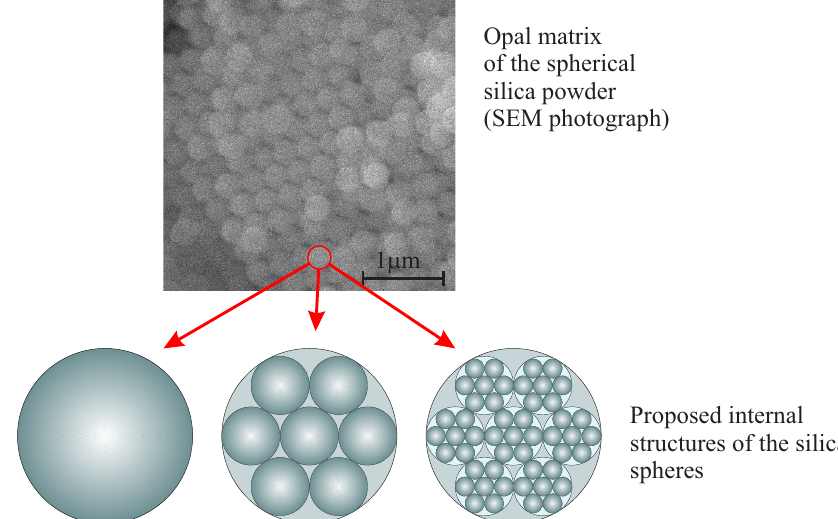
Figure 6. Possible simple models of the interior structure (opal matrix) of silicon dioxide spherical particles.